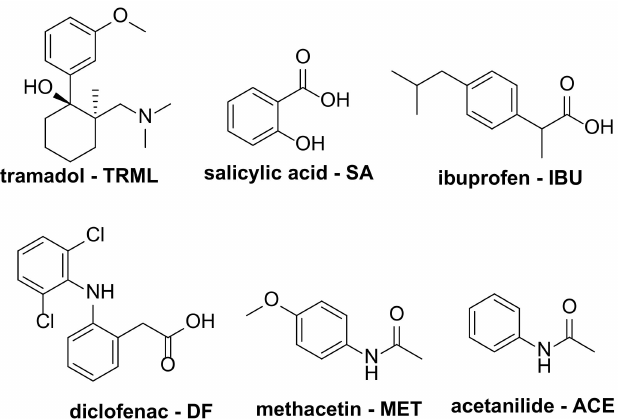
Figure 5. Structures of the analgesics herein discussed.